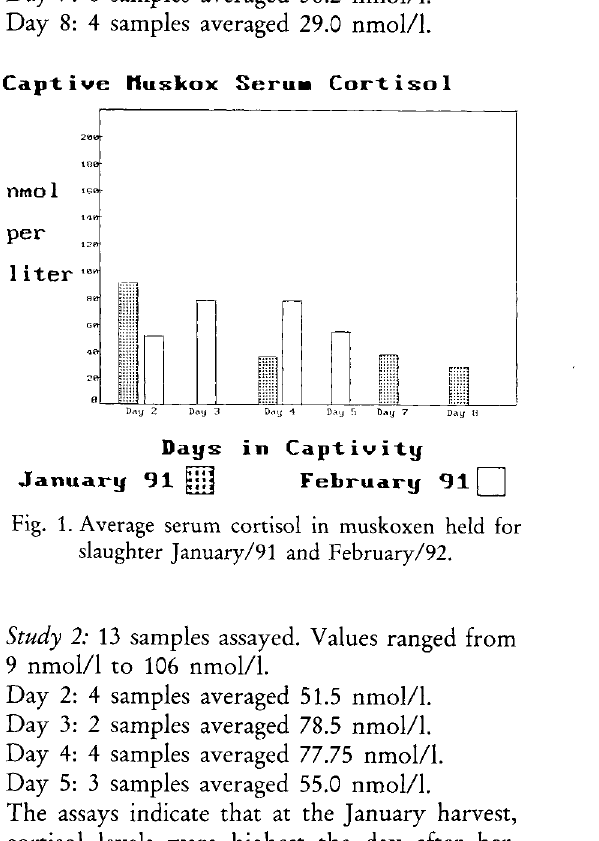
Fig. 1. Average serum Cortisol in muskoxen held for slaughter January/91 and February/92.